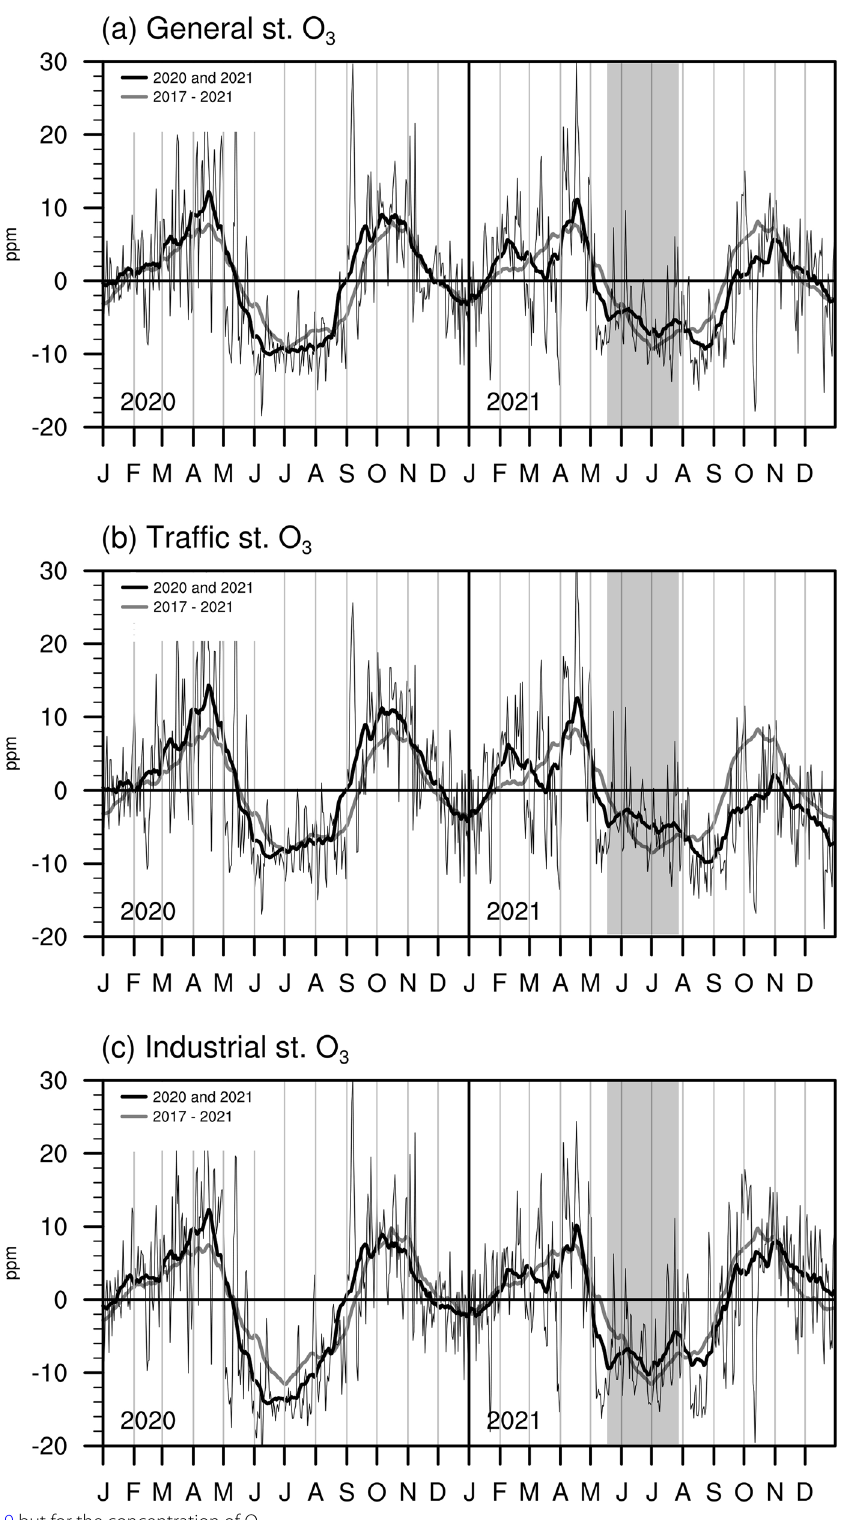
Fig. 11 Same as Fig. 9 but for the concentration of O